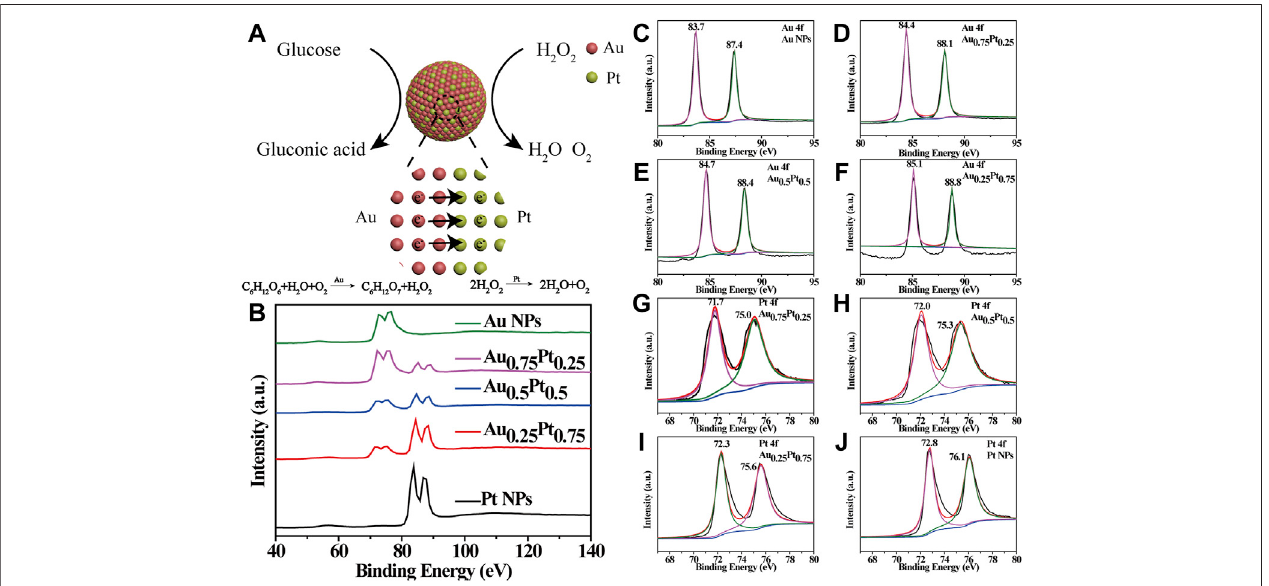
FIGURE3| ElectrondistributionstatesinAuPtalloys. (A) SchematicillustrationofelectrontransferbetweenAuandPt. (B) PartialXPSspectrumofAuPtalloyswith different proportions. Show the representative Au 4f of the (C) Au NPs, (D) Au 0.75 Pt 0.25 , (E) Au 0.5 Pt 0.5 , and (F) Au 0.25 Pt 0.75 . Show the representative Pt 4f of the (G) Au 0.75 Pt 0.25 , (H) Au 0.5 Pt 0.5 , (I) Au 0.25 Pt 0.75 and (J) Pt